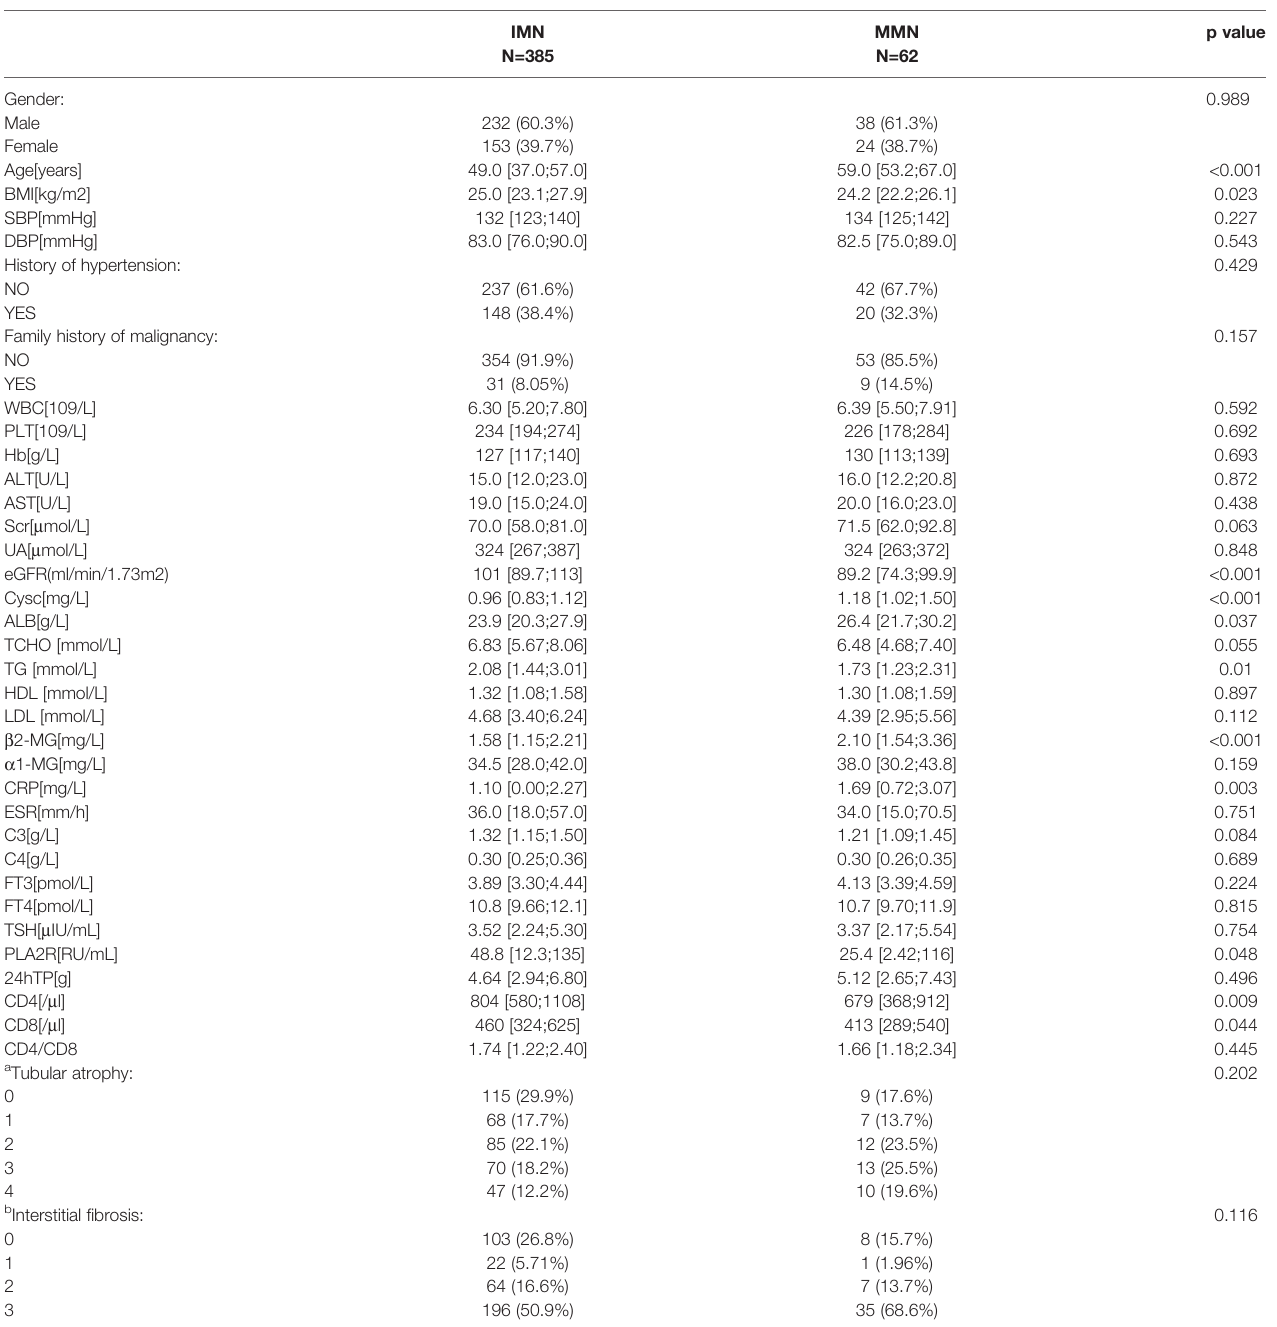
TABLE 1 | Baseline characteristics for all patients with IMN and MMN.